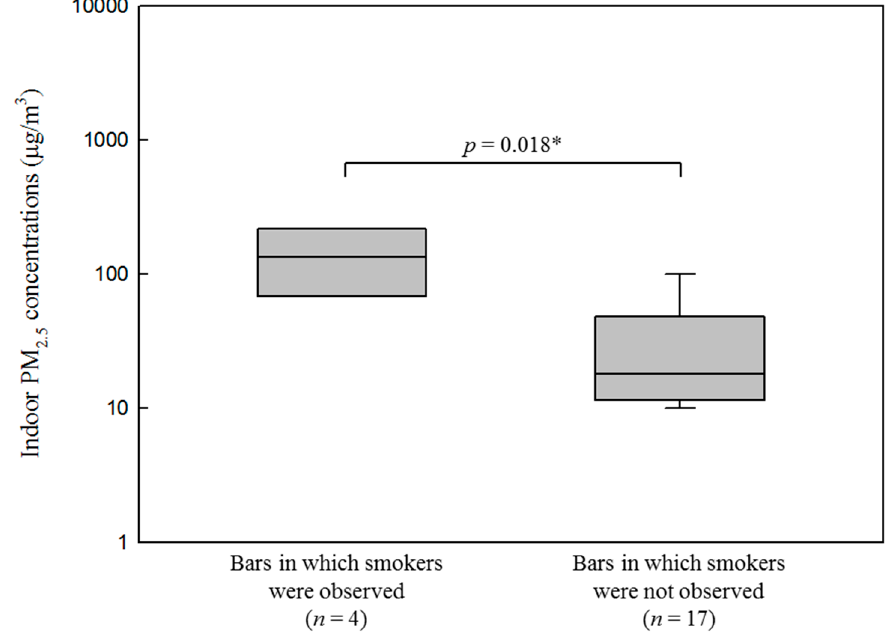
Figure 4. Distribution of indoor PM 2.5 concentrations of bars in which smokers were and were not observed after the smoke-free regulations were implemented in all bars in Changwon. * Wilcoxon’s rank-sum